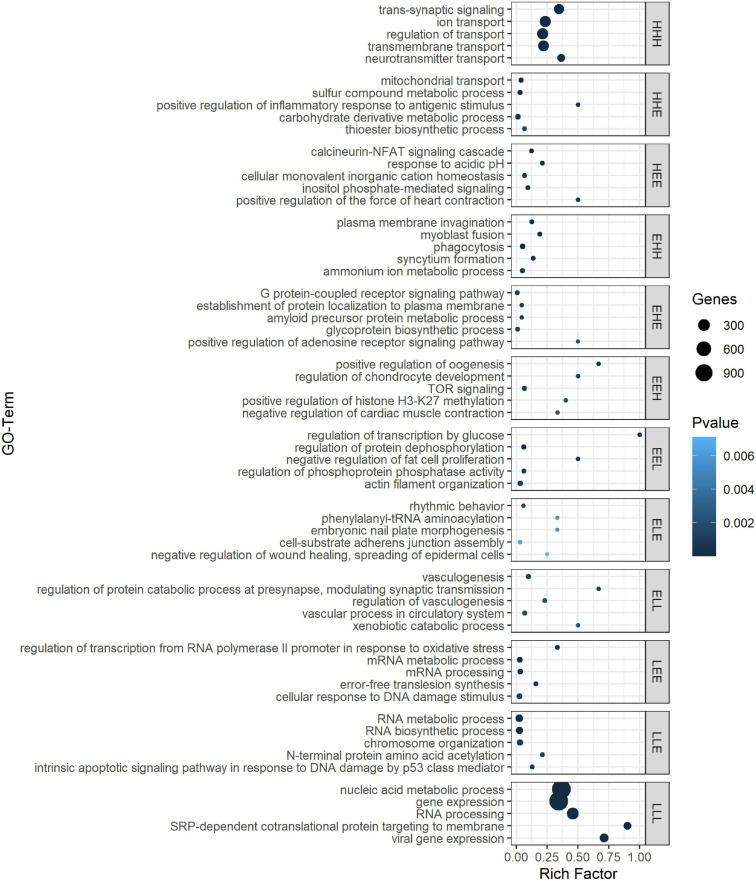
Top 5 ranked GO biological processes for the different gene expression pattern groups. GO terms are sorted by P-value in GePS functional enrichment analysis. For similar GO terms, only the top-ranked GO term was shown. The dot size reflects the number of genes enriched in the GO term and its color the corresponding statistical significance (P-value). Rich factor is the ratio of differentially expressed gene numbers annotated in this GO term to all gene numbers annotated in this GO term. Complete enrichment analysis results are included in Supplementary Table S9). H, higher, L, lower, and E, equal compared with 1 dph as reference.